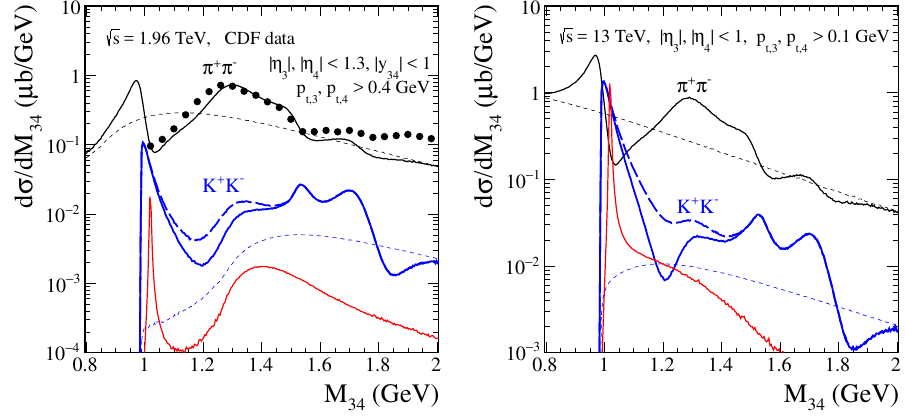
Figure 2. The invariant mass distributions for centrally produced π + π − (the black top lines) and K + K − (the blue bottom lines) pairs with the relevant experimental kinematical cuts specified in the legend. Results including both the non-resonant continuum and the resonances are presented. The short- dashed lines represent the purely di ff ractive continuum term. For the pp → ppK + K − reaction the = 0 and π/ 2 in the coupling solid and long-dashed blue lines correspond to the results for φ f 0 (980) constant g f + K − e i φ f 0(980) , respectively. The lower red line represents the φ (1020) meson plus contin- 0 (980) K uum photoproduction contribution. The CDF experimental data from [10] in the top left panel for the p ¯ p → p ¯ p π + π − reaction are shown for comparison. Absorption e ff ects were taken into account e ff ec- tively by the gap survival factors, (cid:104) S 2 (cid:105) = 0 . 1 for the purely di ff ractive contributions and (cid:104) S 2 (cid:105) = 0 . 9 for the photoproduction